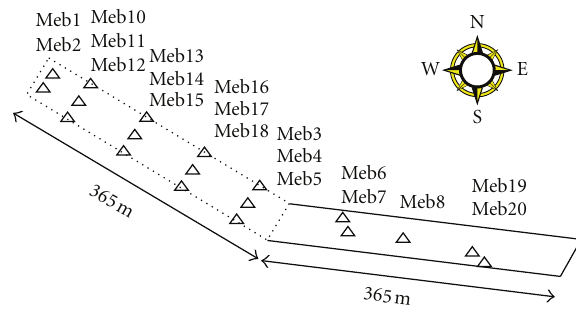
Figure 1: Sampling locations in the drainage